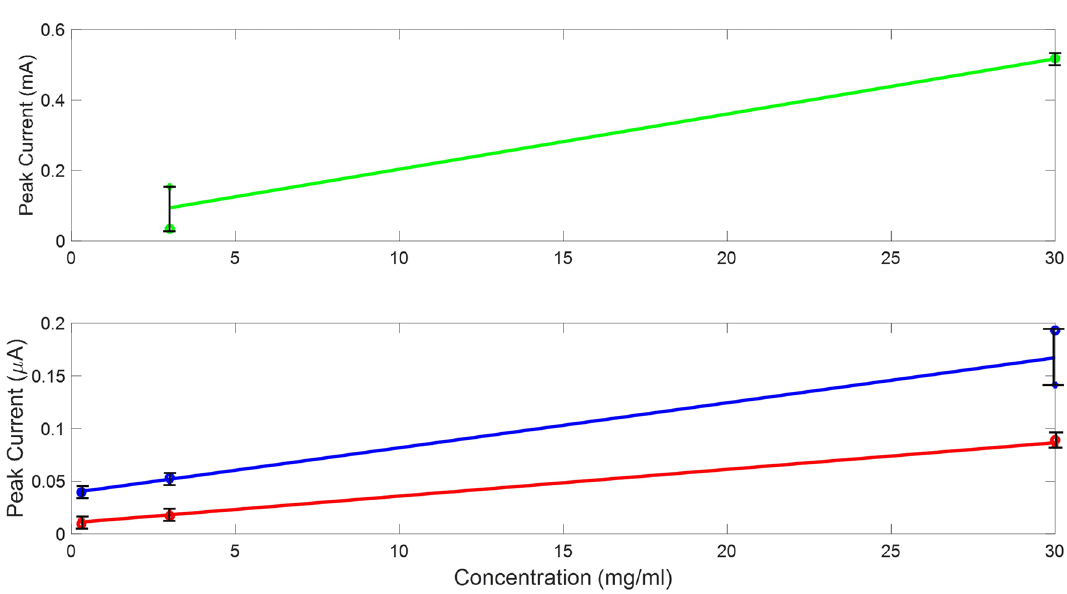
Figure 8. The oxidation peak observed after repeating the experiment twice using three designs (top) Design A, (Bottom) in blue is design B and in red design